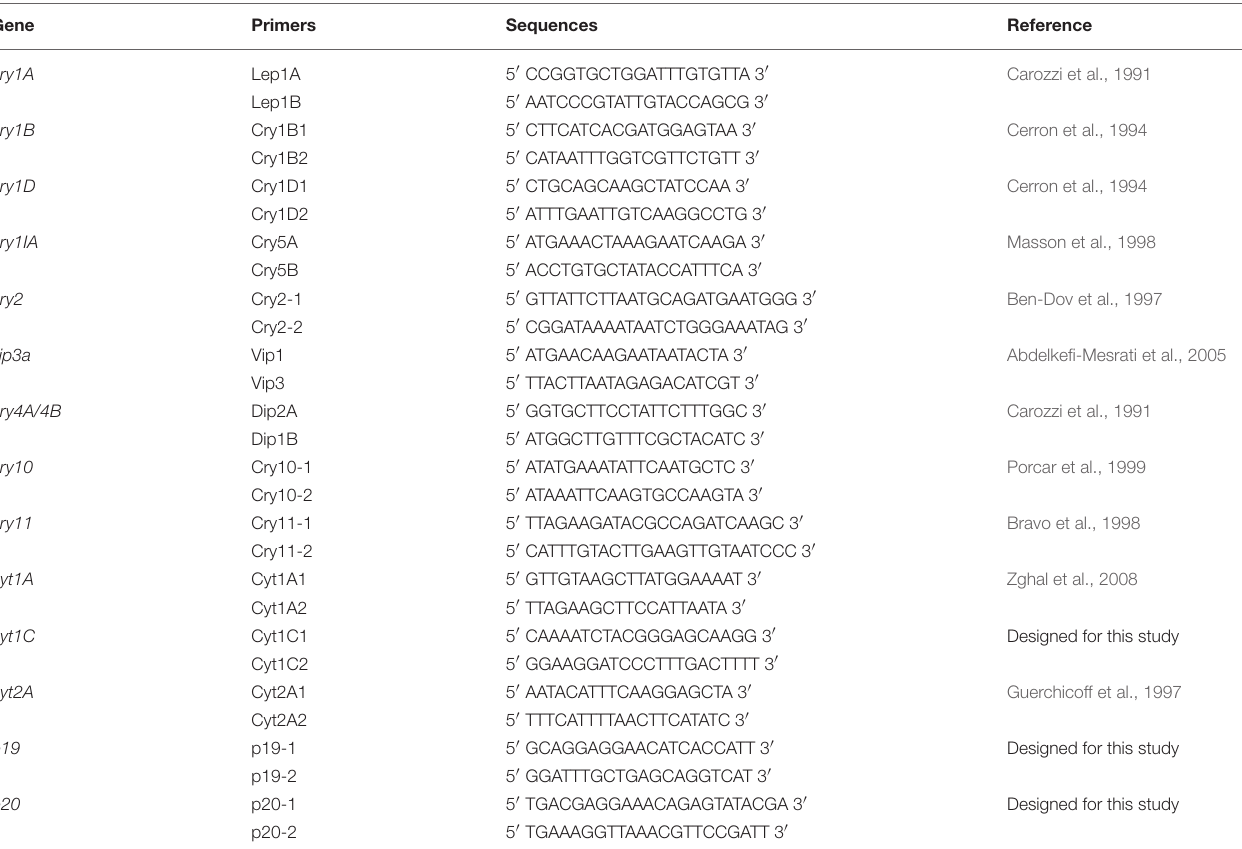
TABLE 1 | Primers used in this study for the exploration of genes encoding endotoxin, accessory proteins and Cyt. Gene